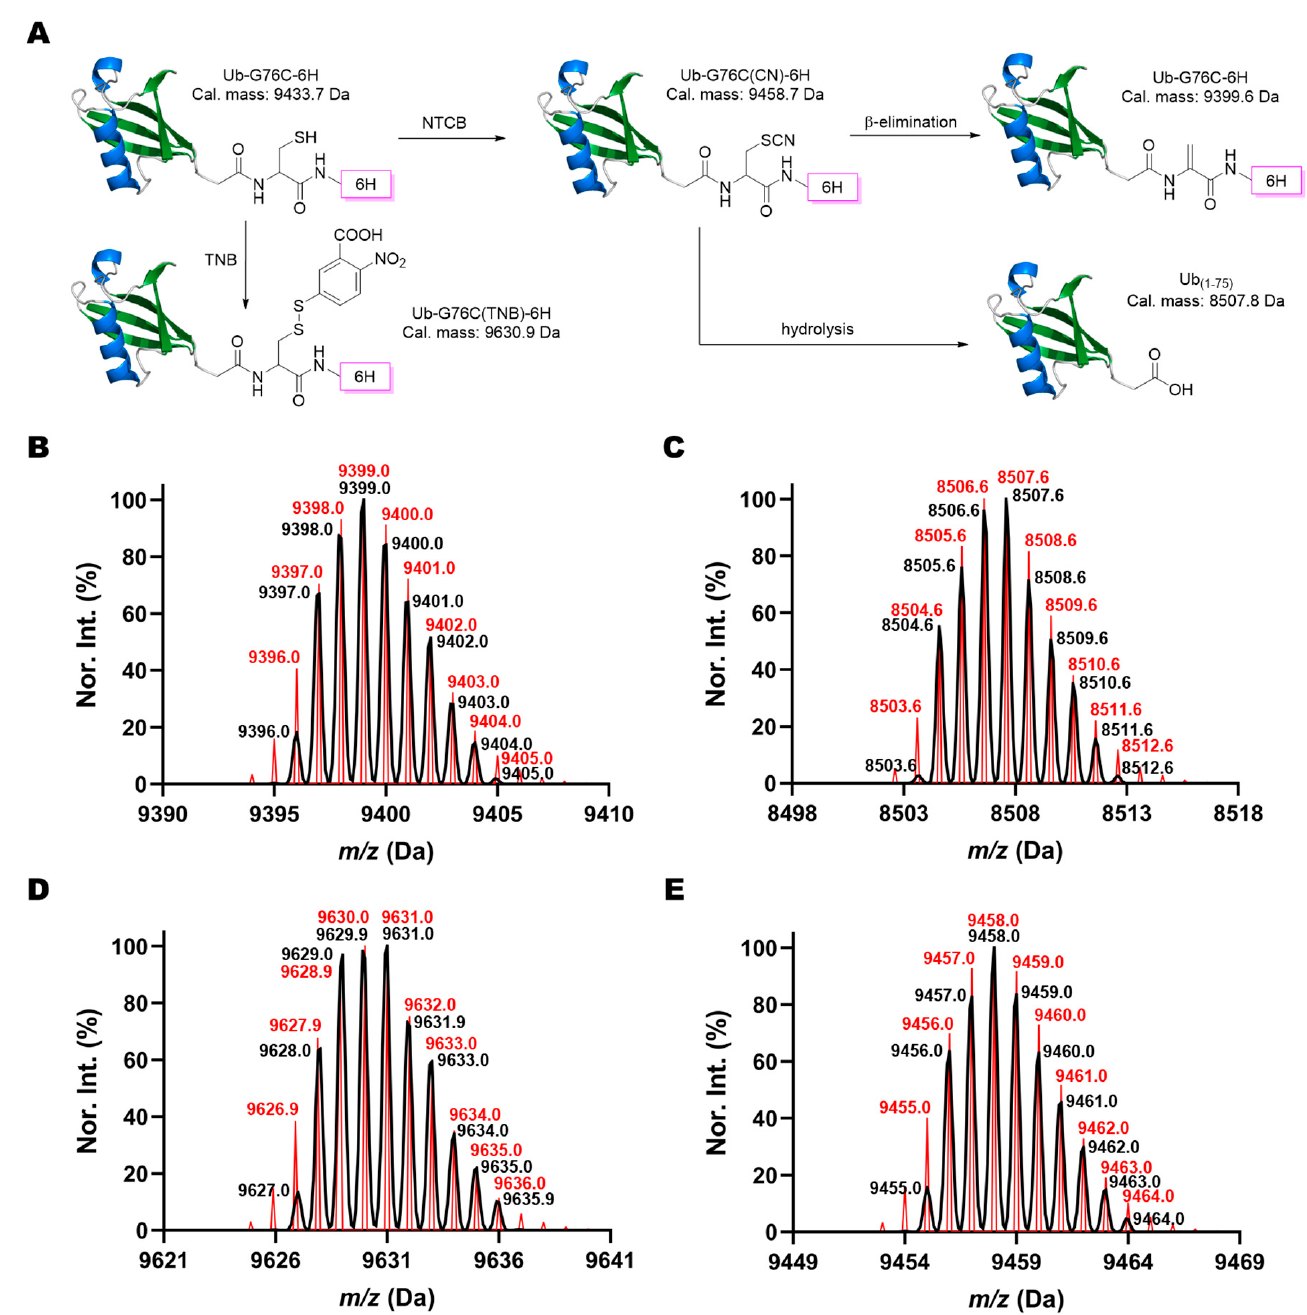
Figure 2. NTCB induced Dha formation in Ub-G76C-6H. ( A ) Pathways for the formation of four different possible products when Ub-G76C-6H reacts with NTCB. Deconvoluted ESI-MS spectra of ( B ) the Dha product Ub-G76Dha-6H, ( C ) the hydrolysis byproduct Ub (1-75) , ( D ) the cyanylated intermediate, Ub-G76C(CN)-6H, and ( E ) the TNB conjugate Ub-G76C(TNB)-6H. Black lines show the detected monoisotopic mass peaks and their relative intensities. Red lines refer to the calculated theoretical monoisotopic peaks and their relative intensities.